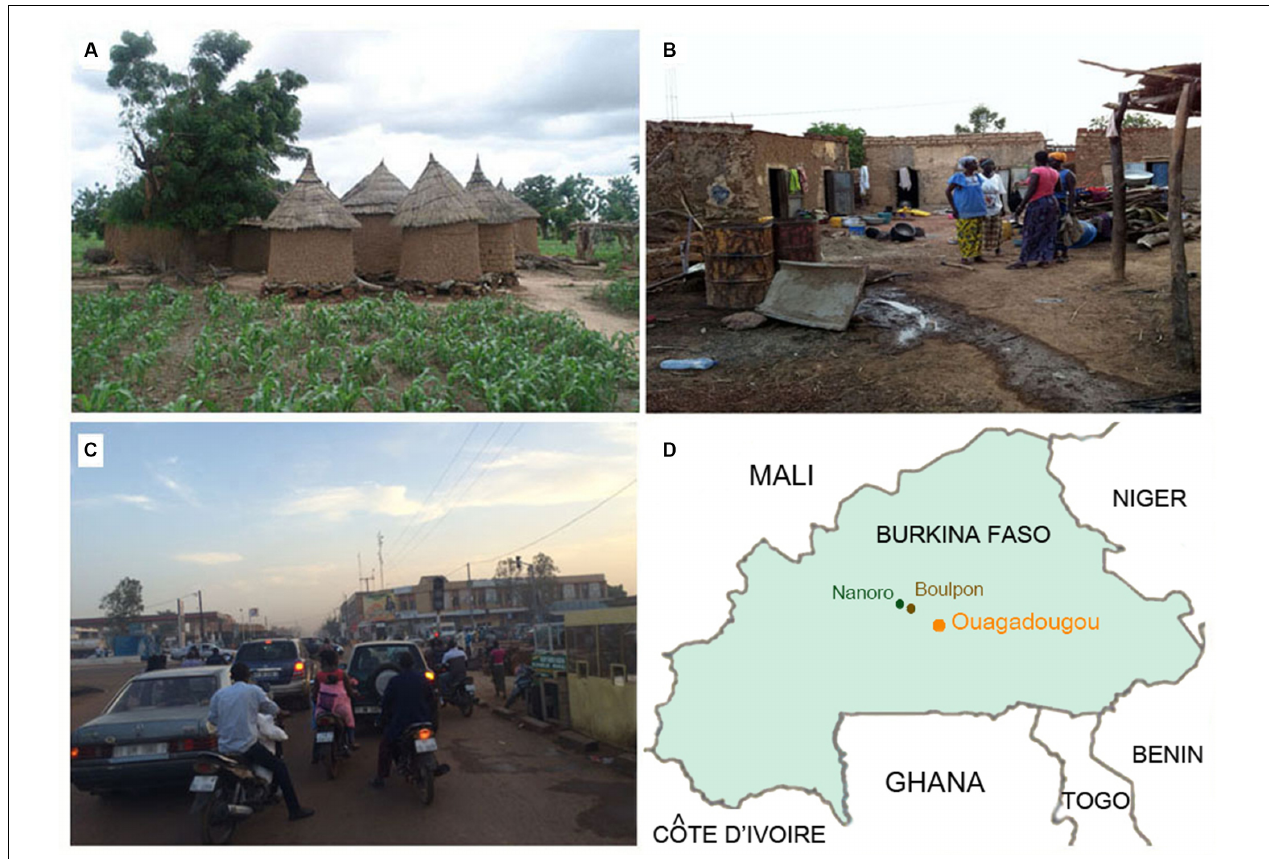
FIGURE 1 | Rural and urban environments in Burkina Faso. (A) Rural village in Boulpon, (B) urban village in Nanoro town, (C) Ouagadougou, the capital city of Burkina Faso (personal photographs of Prof. P. Lionetti), and (D) map of Burkina